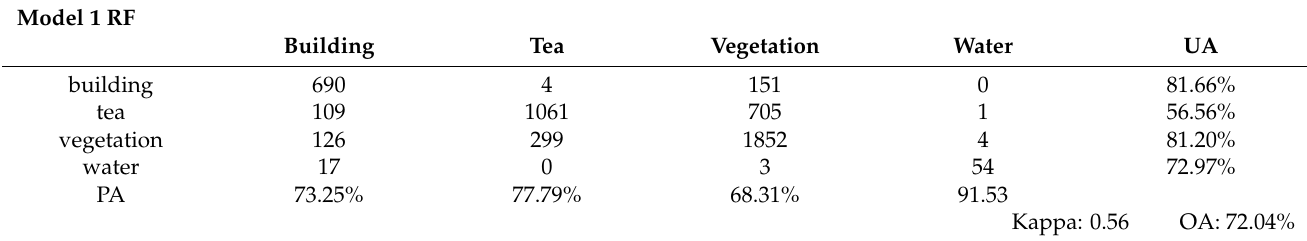
Table 5. Confusion matrices of Models 1, 2, 3, and 4 obtained using RF based on the validation